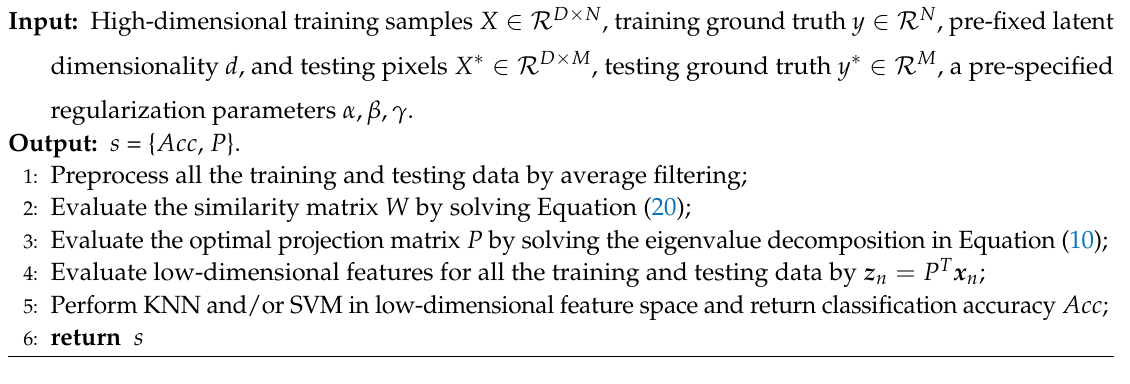
Algorithm 1 LapSaCGDA for HSIs Dimensionality Reduction and